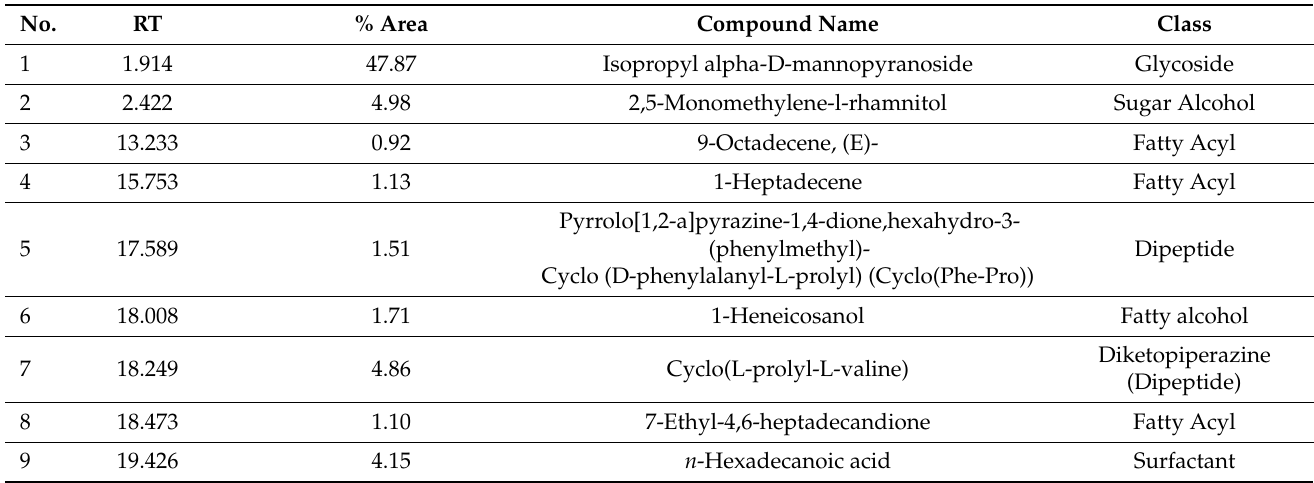
Table 3. Major constituents of the crude biosurfactants of L. rhamnosus using